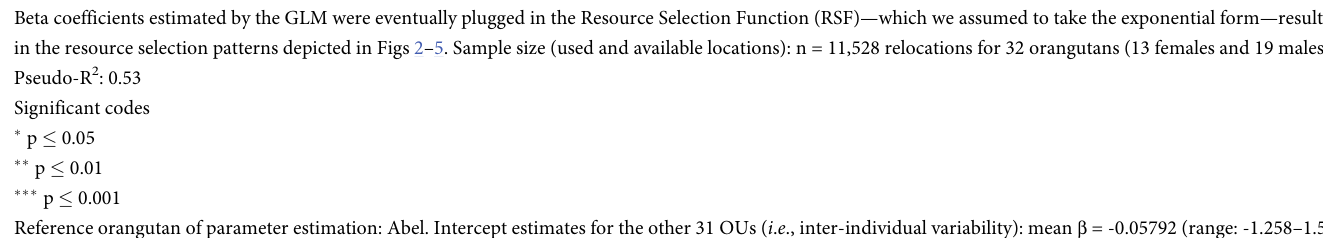
interaction between age and environmental predictors, Table 2 and Fig 2A–2C). Younger orangutans selected for areas closer to the FZS station (Fig 2A). Older individuals, in contrast, showed a stronger selection for areas closer to rivers (Fig 2B) and for areas located at an eleva- tion expected to be optimal for food availability (~200 m a.s.l., Fig 2C). Age of monitored orangutans ranged between 5 and 21 years old. The scenarios depicted in Fig 2 are meant to show the development of resource selection patterns in our tracked orangutans as a function of their age, from younger to older ones. See supplementary information for detailed model predictions (S9 and S10 Figs) and for a comprehensive overview of the shift in resource selec- tion patterns in increasingly older monitored individuals. We found that the time spent in rehabilitation affected resource selection patterns (signifi- cant interaction between time spent in rehabilitation and environmental predictors, Table 2